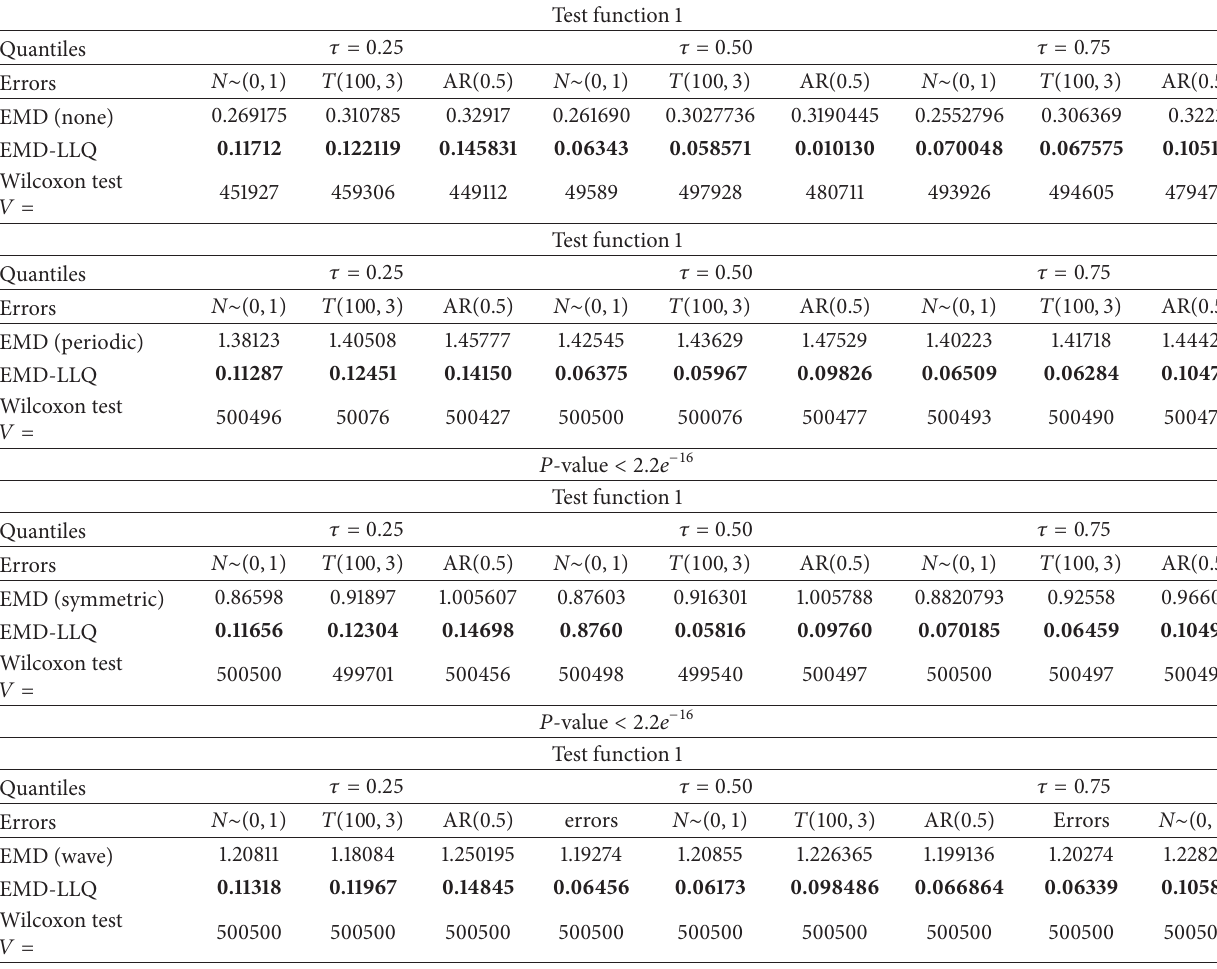
Table 2: The MSE of the classical EMD and proposed method under variety of boundary solution noise structure, different values of quantile 𝜏 (0.25, 0.50, and 0.75), and sample size